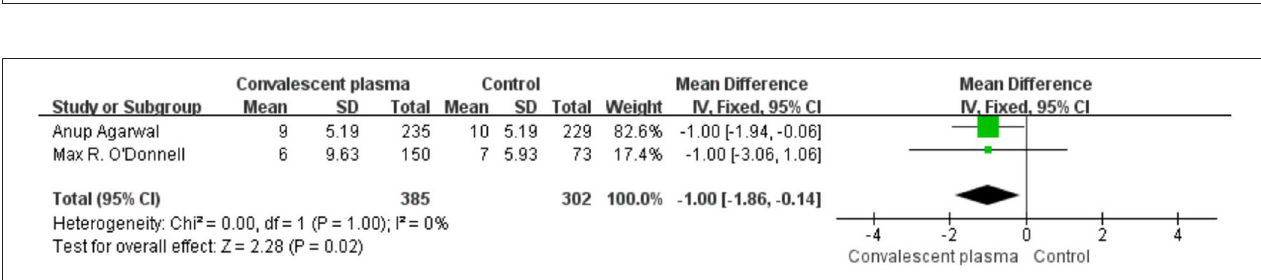
FIGURE 7 | Forest plot of mean difference (MD) of ICU stay among patients treated with convalescent blood products and controls ( n = 2 studies). Weights are from fixed-effects analysis. CI, confidence interval; ICU, intensive care unit.